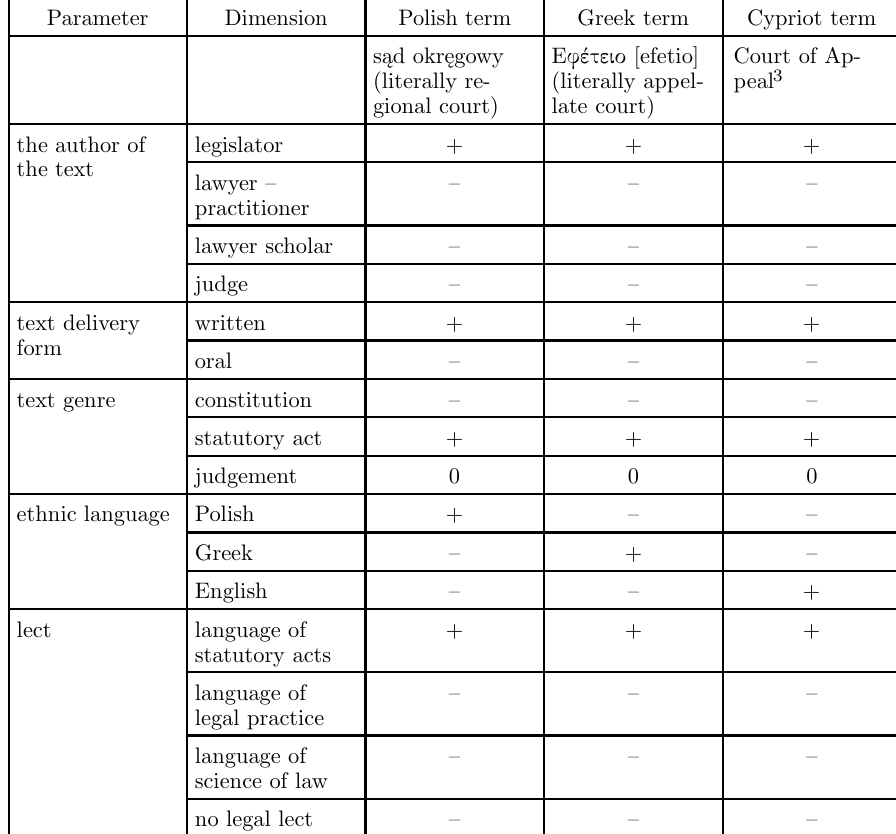
Court of 2nd instance. Parametric